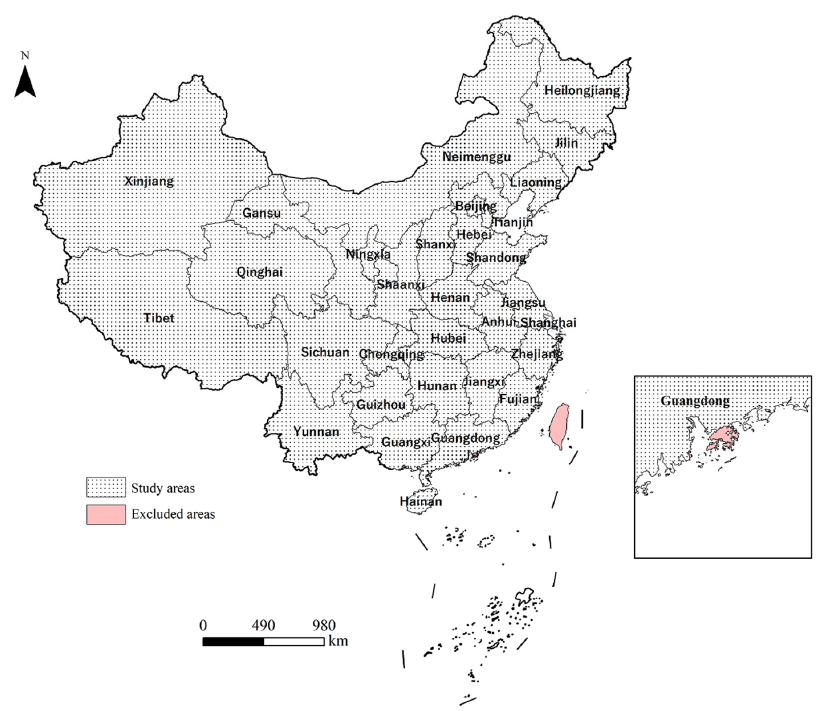
Figure 1. Location of study areas.